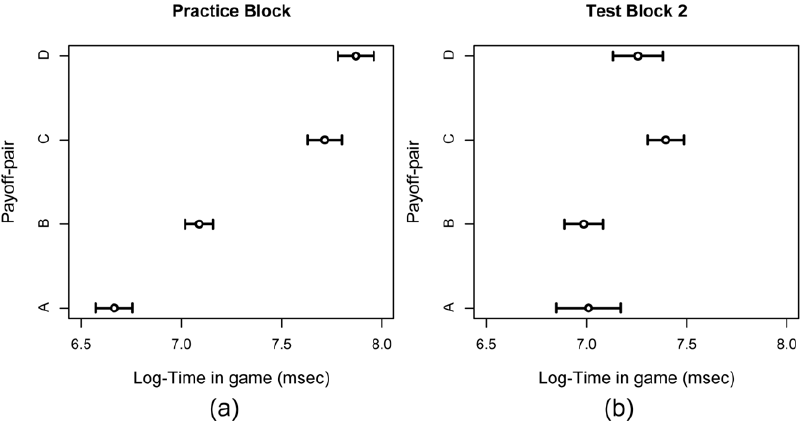
Figure 4. The logarithm of the onset times (in msec) of fixations on each payoff-pair. The onset times are depicted separately for the practice block (a) and Test Block 2 (b). The error bars represent standard